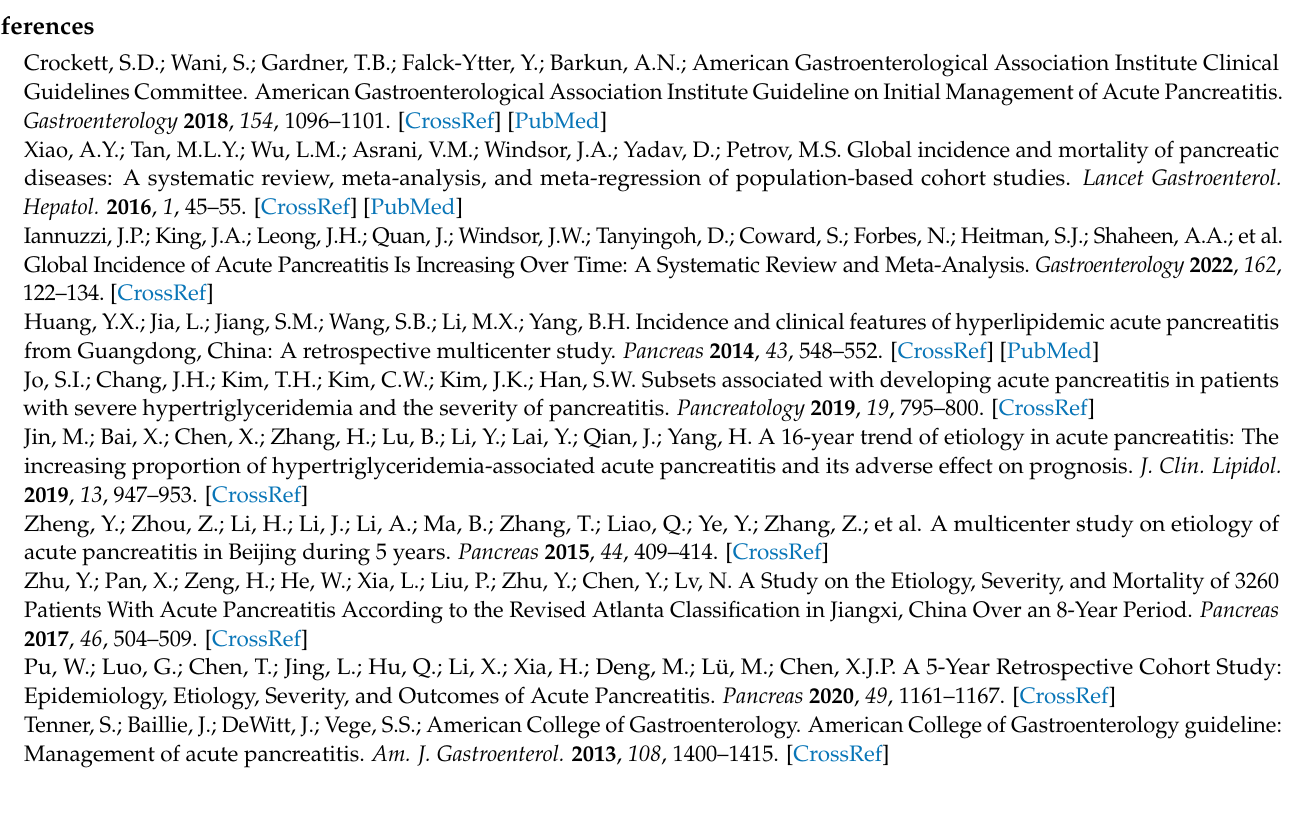
Table S4. Comparison of clinical characteristics in patients in DW group and WDW group; Table S5. Comparison of clinical scoring systems and laboratory findings in patients in DW group and WDW group; Table S6. Univariate logistic regression analysis for SAP among DW group, WDW group and WA group; Table S7. Univariate logistic regression analysis for necrotizing pancreatitis among DW group, WDW group and WA group. References [24,25] are cited in the supplementary